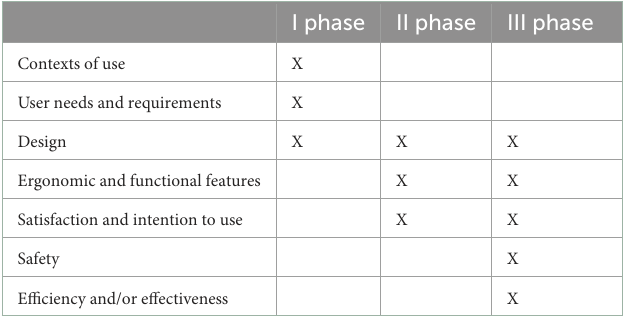
TABLE 2 Outcomes in each phase of the study.